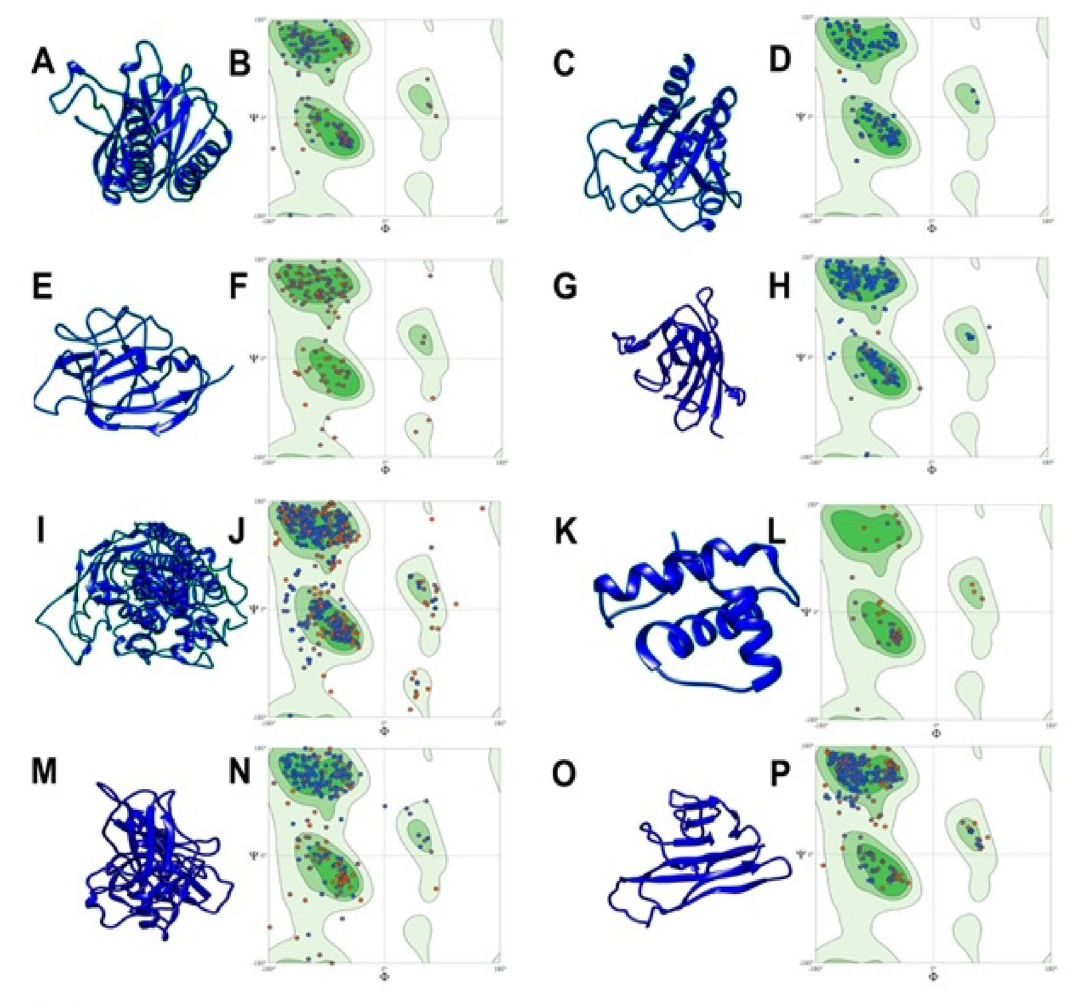
Figure 9. Modeling of three-dimensional structures for rat proteins. ( A ) 3D image of COX2. (B ) Ramachandran plot of COX2. (C) 3D image of GPx. (D) Ramachandran plot of GPx. (E) 3D image of IL-1. ( F ) Ramachandran plot of IL-1. (G) 3D image of SOD. (H) Ramachandran plot of SOD. ( I ) 3D image of STAT3. (J) Ramachandran plot of STAT3. (K) 3D image of NF-κB. ( L ) Ramachandran plot of NF-κB. (M) 3D image of P65. (N ) Ramachandran plot of P65. ( O ) 3D image of TNF-α. (P) Ramachandran plot of